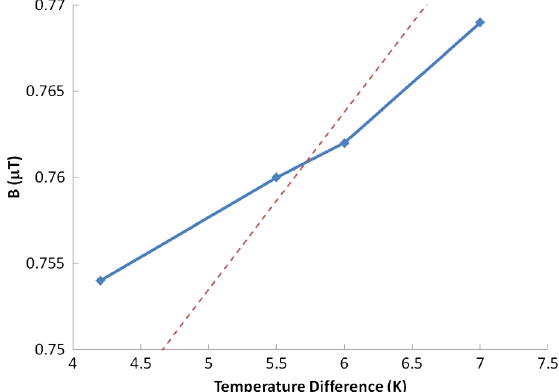
FIG. 4. Measured magnetic field as induced by the thermo- current (solid line). The lower temperature transition was held at 9 – 10 K. The extrapolated field for Δ T approaching 0 K is the residual magnetic field inside the cryostat. The dashed line is the expected magnetic field using Eq. (3) – (5). For details see